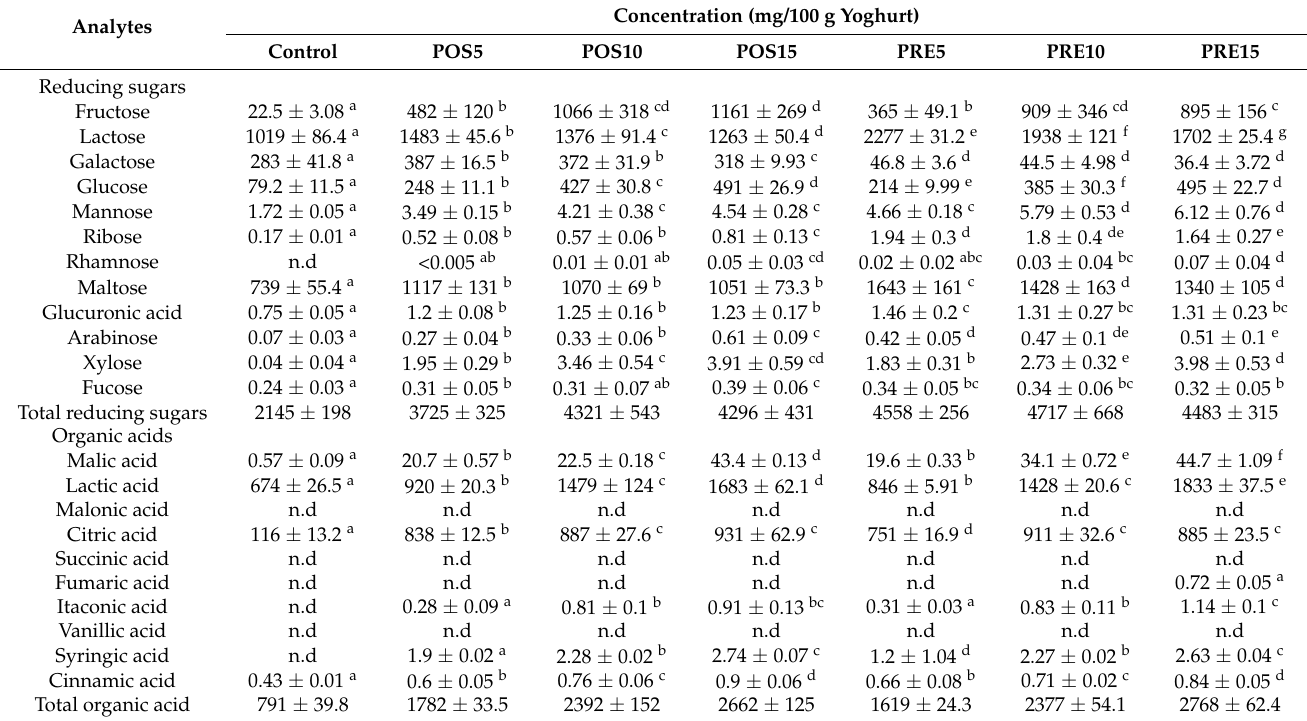
Table 3. Reducing sugar and organic acid profiles of yoghurt